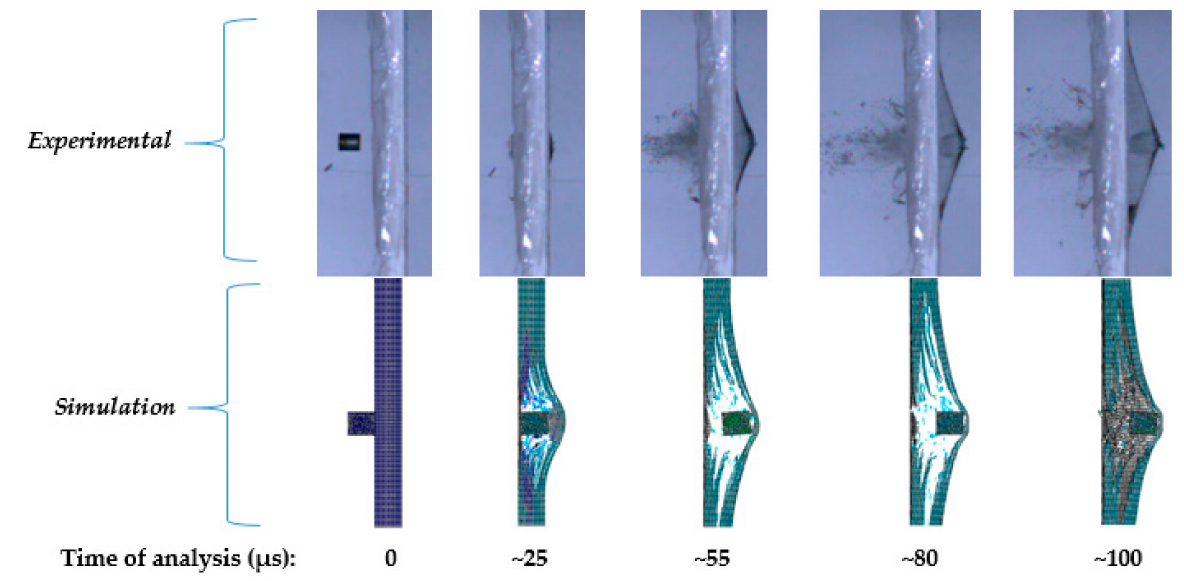
Figure 11. Sequential time steps after the ballistic impact, Vinitial = 606